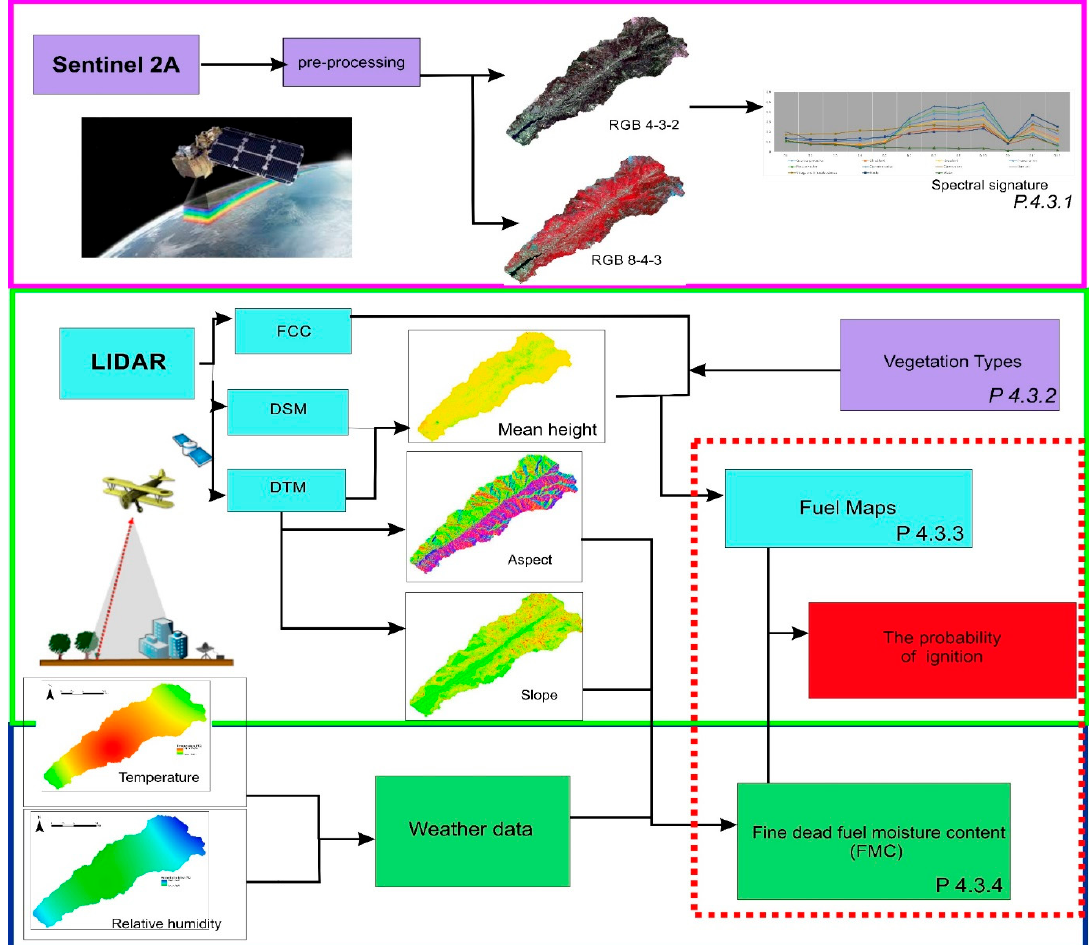
Figure 2. Methodological diagram. Table 3. Characteristics of fuel models.